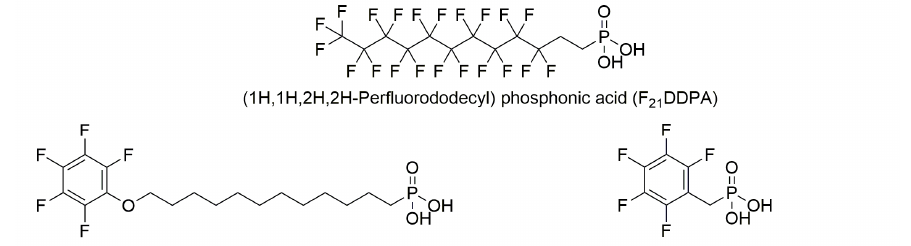
Figure 1. Molecular structures of the perfluorophosphonic acids used to modify the Zinc oxide (ZnO) nanoparticles.